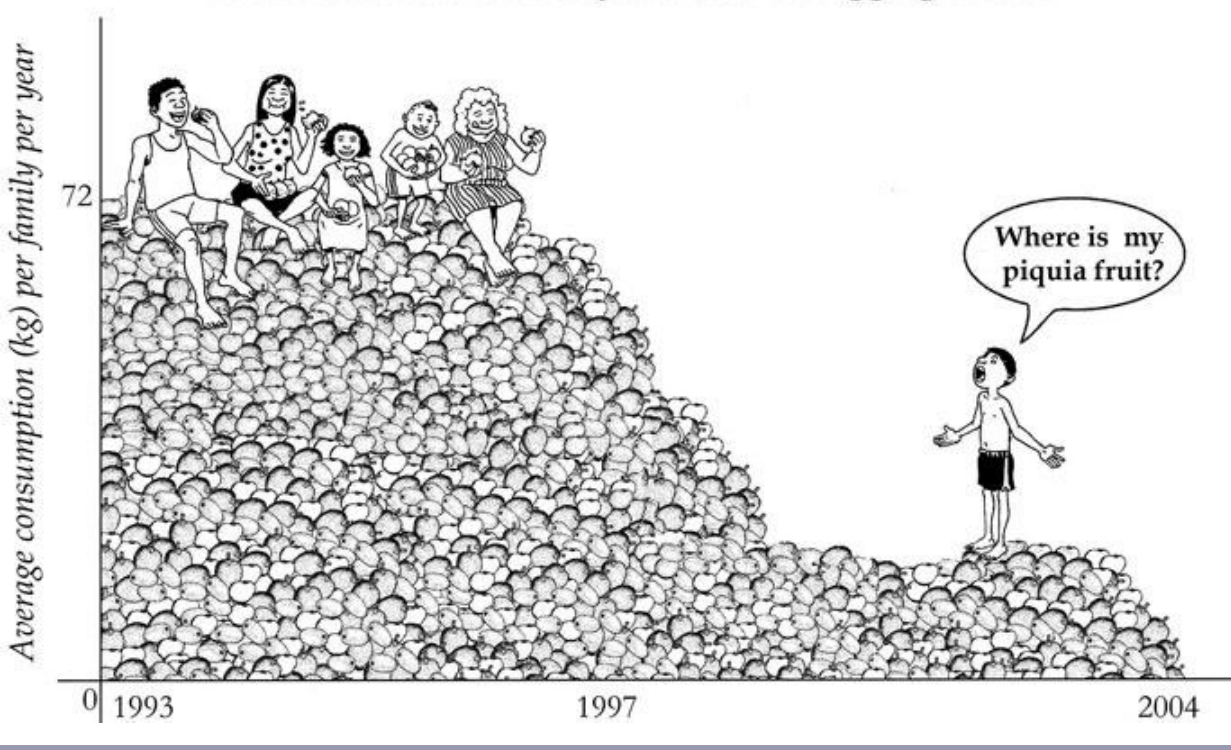
Fig. 6. Timber extraction can be compatible with the use of forest products such as fruits, depending on the frequency and intensity of extraction. Source: Shanley and Medina